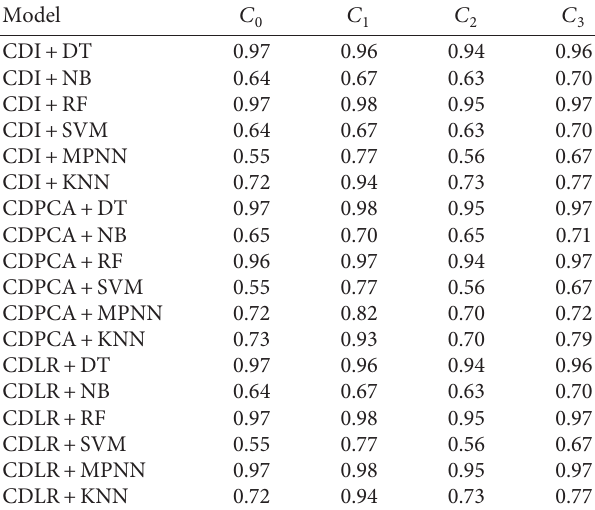
Table 12: The ROC curve final mixture of the performance results with multiclass cross validation with N � 10.